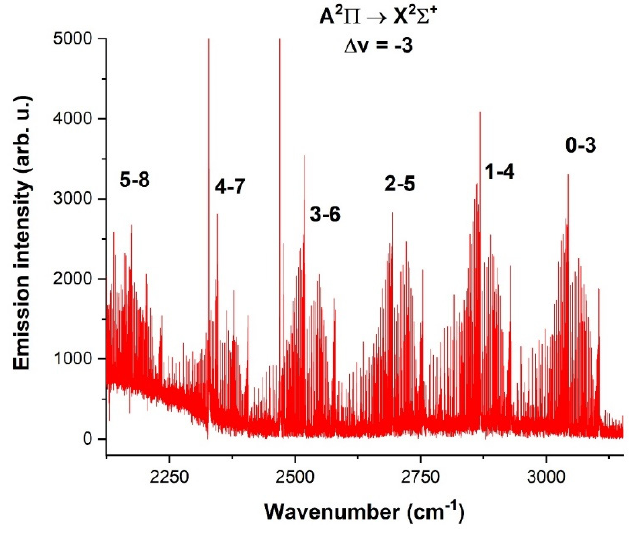
Figure 23. Spectrum of electronic bands of CN radical for the ∆ v = − 3 sequence (39 µ s). A sequence of the ∆ v = − 2 of A 2 Π → X 2 Σ + transition type of the CN radical, lying in the 4350–5150 cm − 1 spectral range, is depicted in Figure 24 and was obtained by the use of (CN) 2 , with a pulse width of 22 and 14 µ s after the pulse ended. The spectral resolution was 0.05 cm − 1 , and 50 scans were accumulated to obtain a reasonable signal-to-noise ratio. The electric voltage was 1.4 kV, and the electric current was 100 mA.